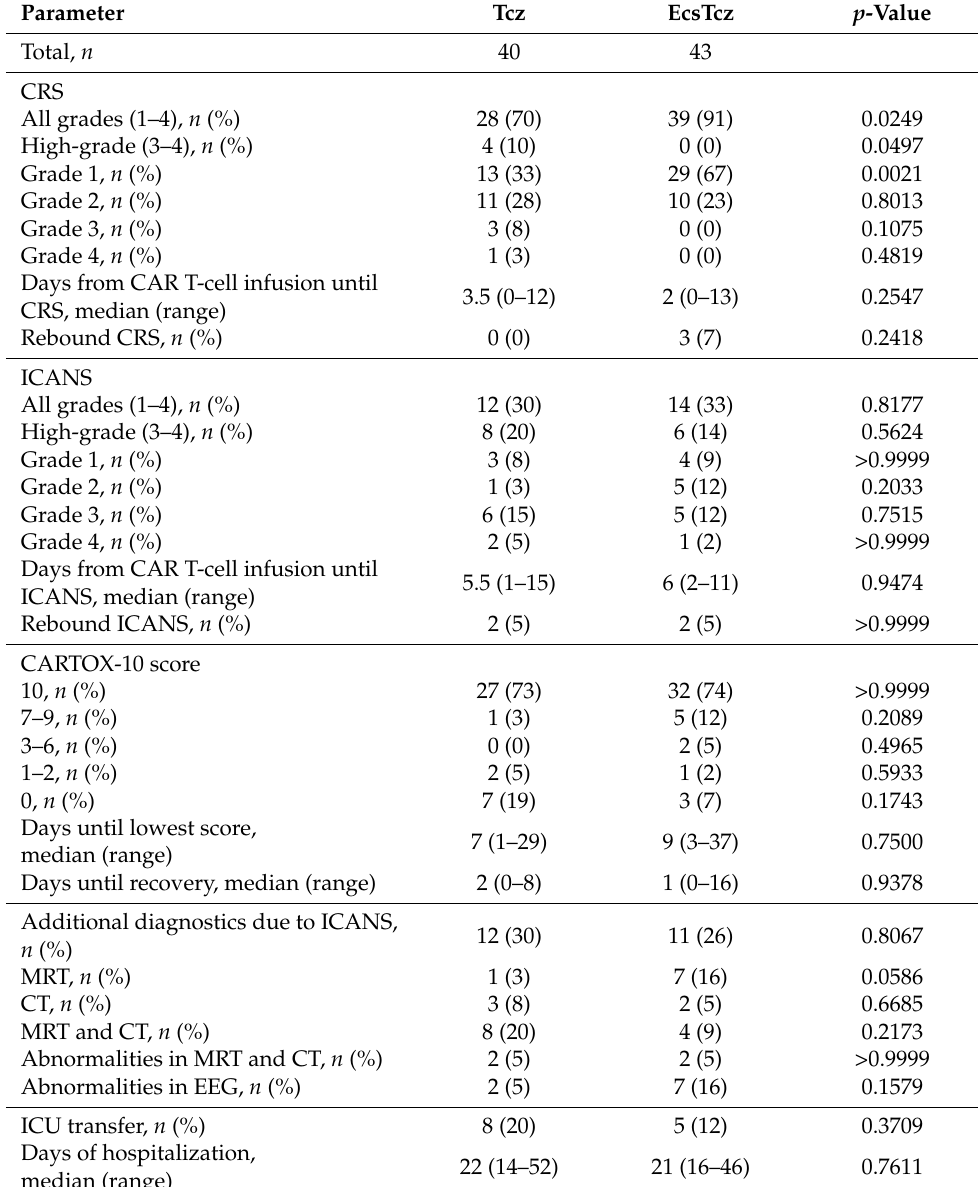
Table 3. Comparison of adverse events from CAR T-cell therapy in cohorts Tcz vs.